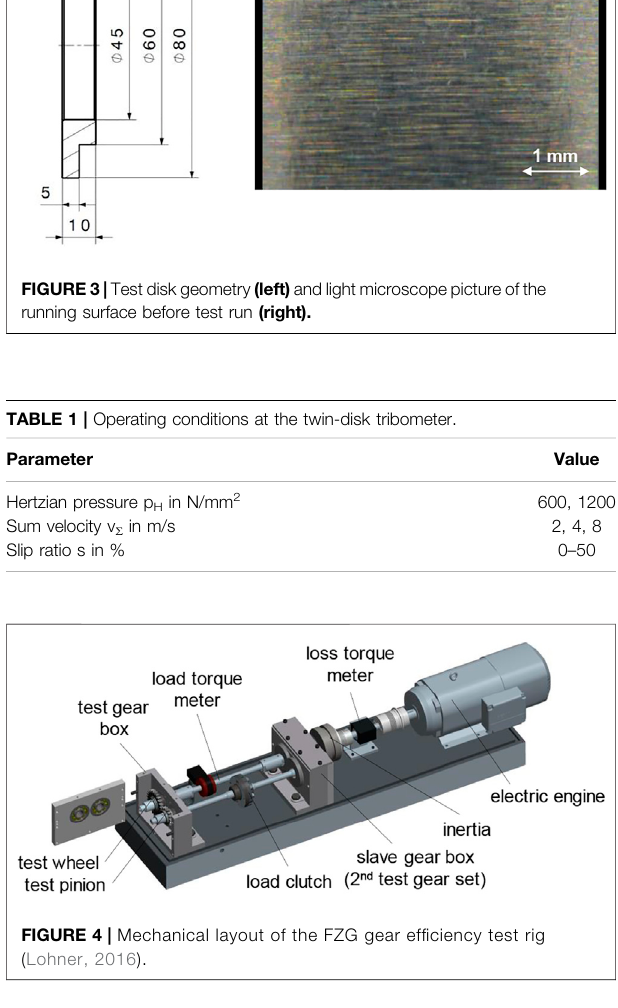
Frontiers in Mechanical Engineering |